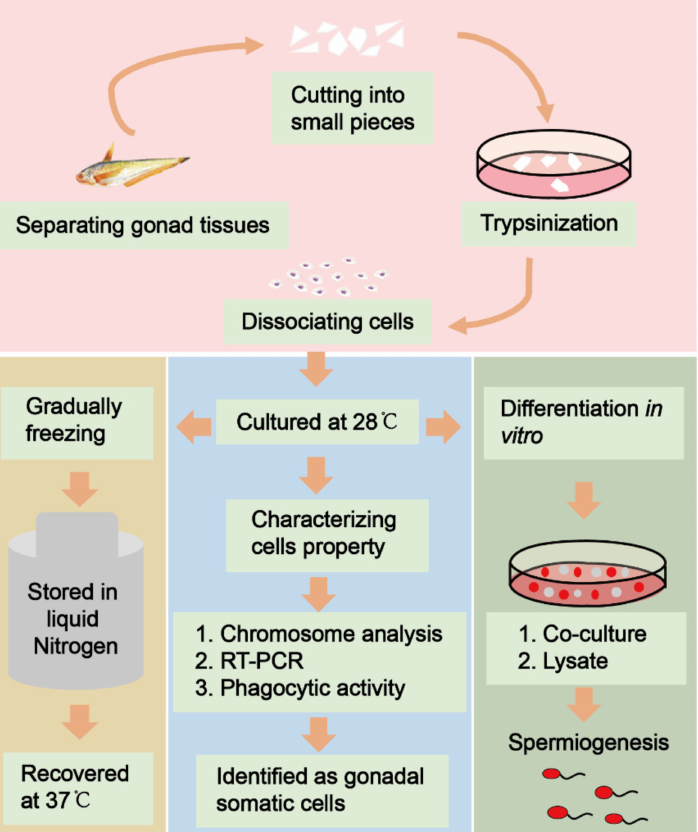
Figure 1. The flowchart of experiments. In total, 12 sex-indeterminate adult fish of 1.5 years old having a length of about 20–30 cm were used in this study. Live fish were placed on ice and executed. All gonadal tissues were dissected and washed three times with phosphate-buffered saline (PBS) containing antibiotics. They were cut into small pieces to dissociate cells by trypsinization. The stable cell lines were obtained by suitable culture and then frozen for storage. We verified that the cells were gonadal somatic cells by chromosome analysis, RT-PCR, and phagocytosis assay. Most importantly, spermatogonial stem cells were induced to differentiate into elongating spermatids by a co-culture system or gonadal somatic cell lysate culture